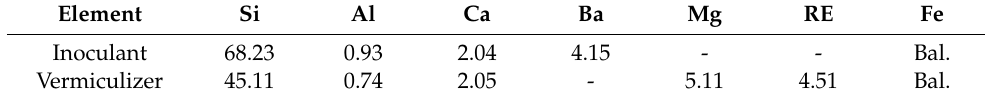
Table 1. Chemical composition of inoculant and vermiculizer (wt.%).